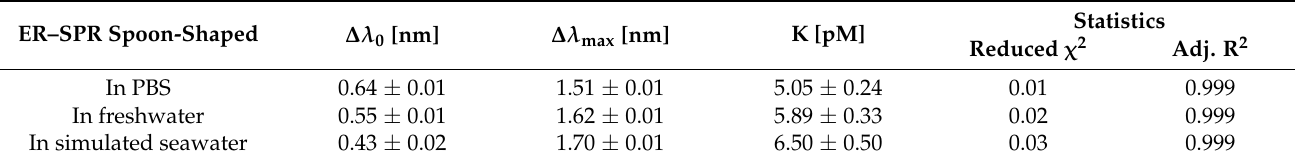
Table 1. Langmuir parameters of estradiol detection in PBS, freshwater, and in simulated seawater.